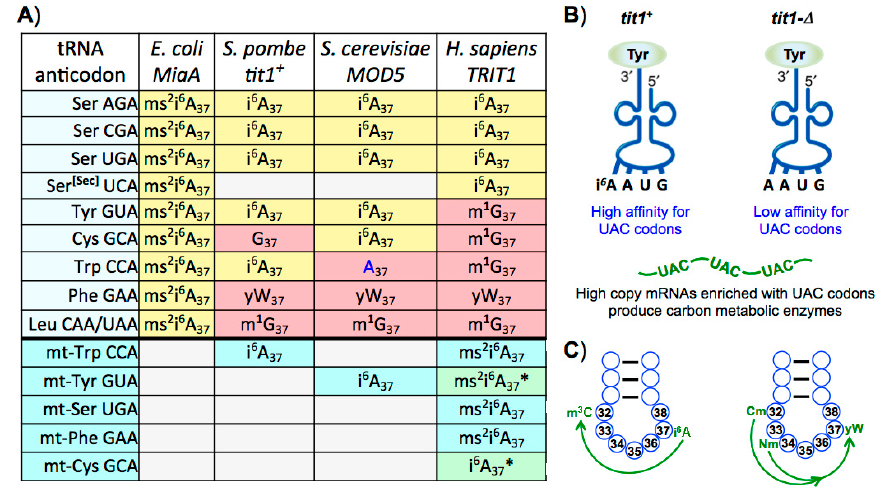
Figure 5. Species ‐ plasticity in i 6 A37 ‐ associated anticodons, potential for secondary code information use and position 37 modification interdependence. ( A ) Summary of i 6 A 37 ‐ associated anticodons in four species. The gene names for the tRNA isopentenyltransferases that form i 6 A 37 are provided under the species names in the top row. The anticodons above the thick horizontal are for cytosolic tRNAs and below are mitochondrial tRNAs; asterisks reflect data from bovine not human; data from [127,130–132]. ( B ) Summary of effect of i 6 A 37 on decoding activity and translation by tRNA Tyr GAU in Shizosaccharomyces pombe , depicted as a cartoon (see [102,133]). ( C ) Crosstalk or interdependence among modifications of position 37 nucleotide and other modifications in the anticodon loop of eukaryotic tRNAs. Left panel: m 3 C 32 is dependent on i 6 A 37 [134]. Right panel: dependence of yW37 on the ribose methylations at positions 32 and 34 [135,136] . E. coli : Escherichia coli; S. pombe : Shizosaccharomyces pombe; S. cerevisiae : Saccharomyces cerevisiae ; H. sapiens : Homo sapiens .